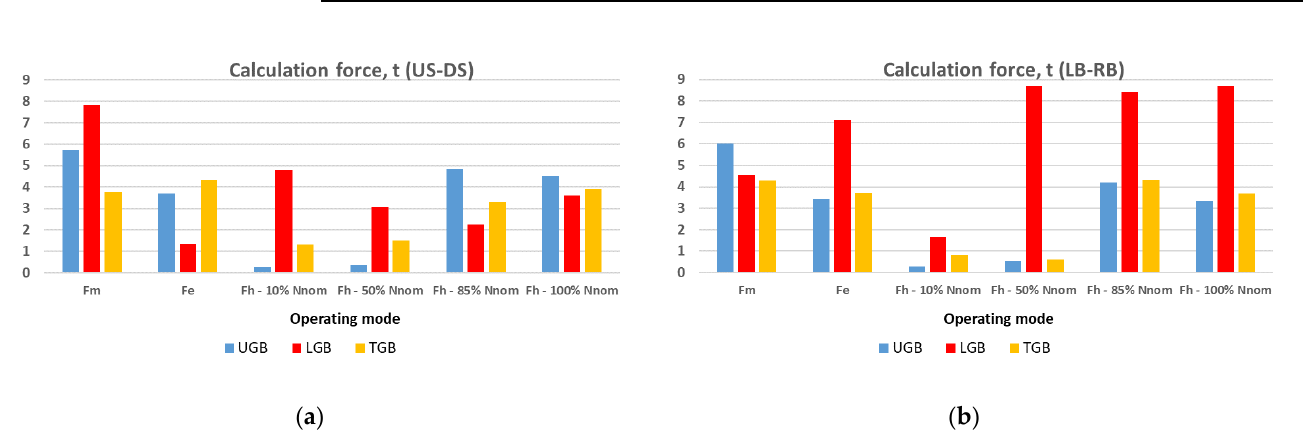
Figure 4. Force impacts on the shaft of the unit (t): ( a ) upstream-downstream direction (US-DS); ( b )